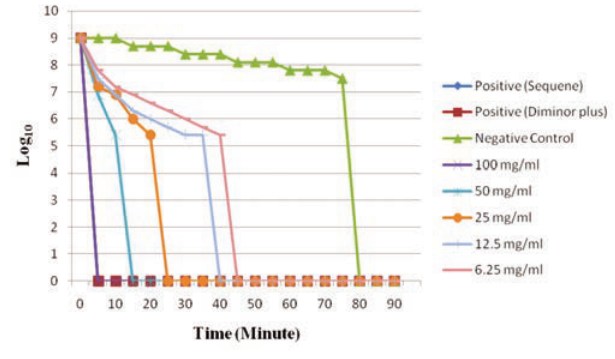
Figure 1. Chloroform Extract of Punica granatum L. against Trypanosoma brucei brucei.